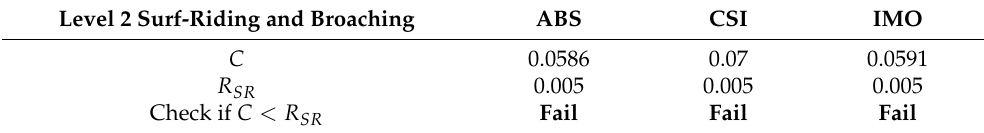
Table 40. Level 2 assessment of surf-riding and broaching failure mode for fishing vessel.